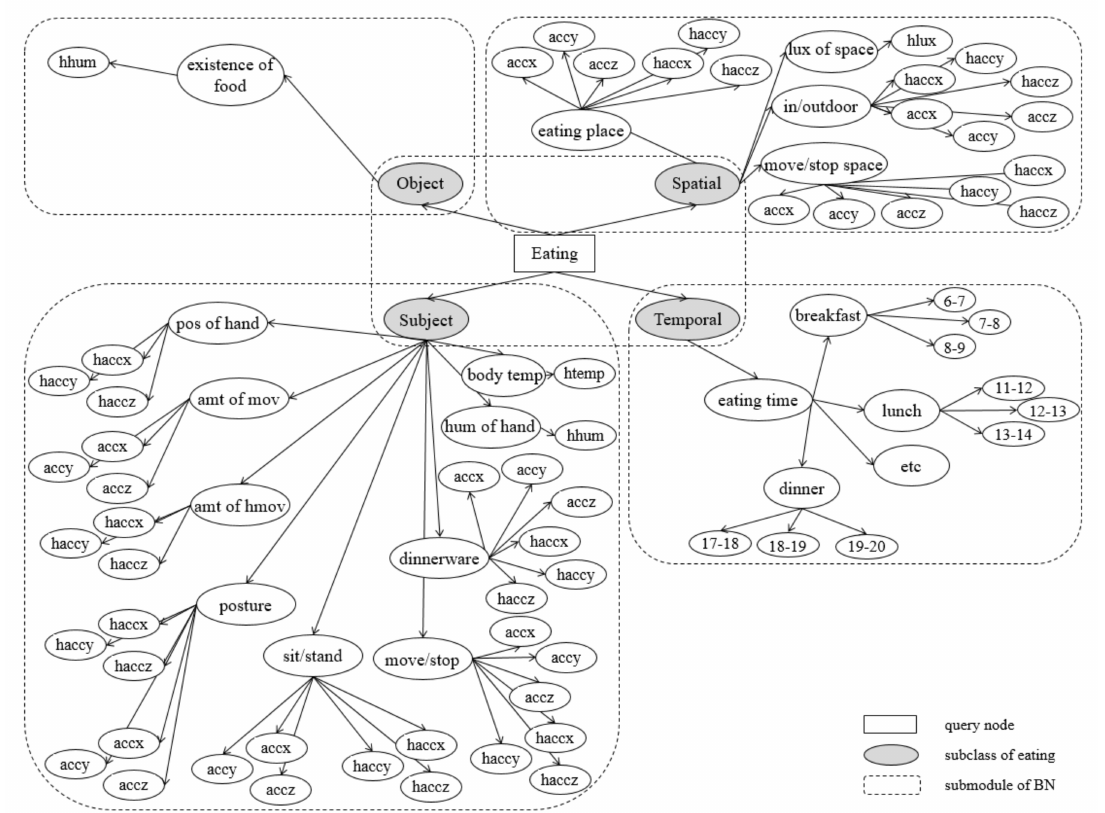
Figure 4. The proposed Bayesian